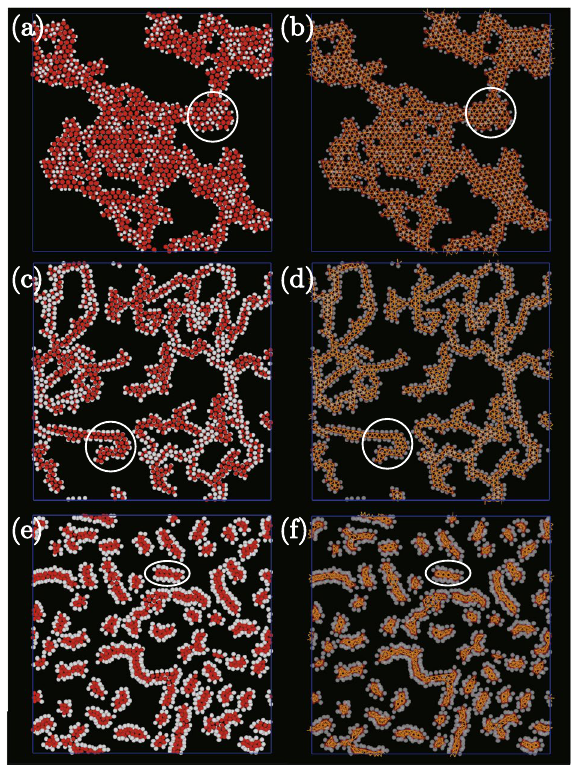
8.0 as viewed from the z -direction. The parameter Figure 2. Typical snapshots of large clusters for ǫ/ k B T = setting for ( l , q ) are ( a ) and ( b ) (0.70, 0.70), ( c ) and ( d ) (0.50, 1.05), and ( e ) and ( f ) (0.85, 1.05). Only particle positions are drawn in ( a ), ( c ), and ( e ). The white and red areas show the non-interacting and attracting areas, respectively. In ( b ), ( d ), and ( f ), in addition to the particle positions, attracting particles are connected by lines.